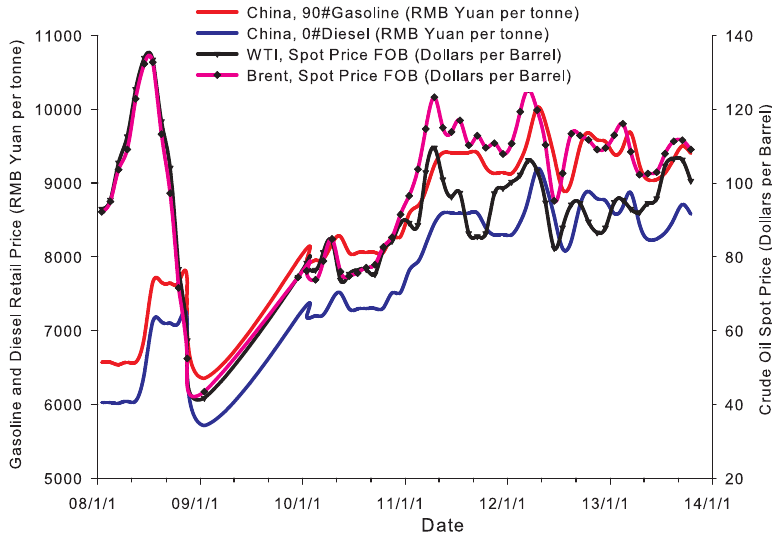
Figure 5. China’s gasoline and diesel retail prices and international crude oil spot price (source: National Bureau of Statistics of China (NBSC) and U.S. Energy Information Administration